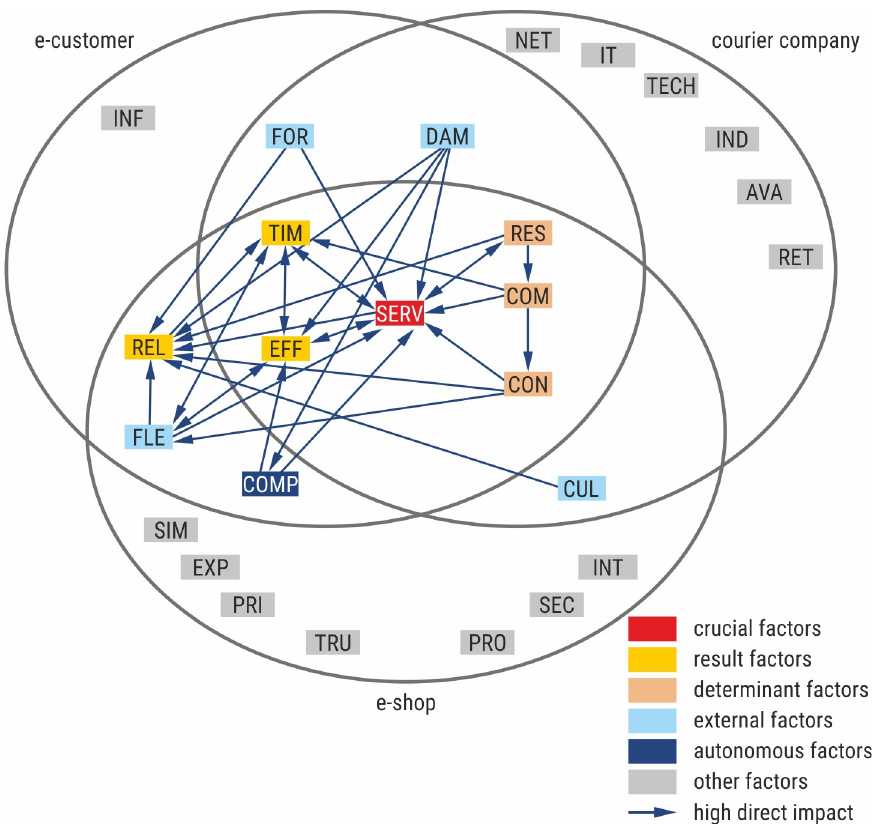
Fig 4. Relational model of courier service quality in the B2C e-commerce sector. Source: Own